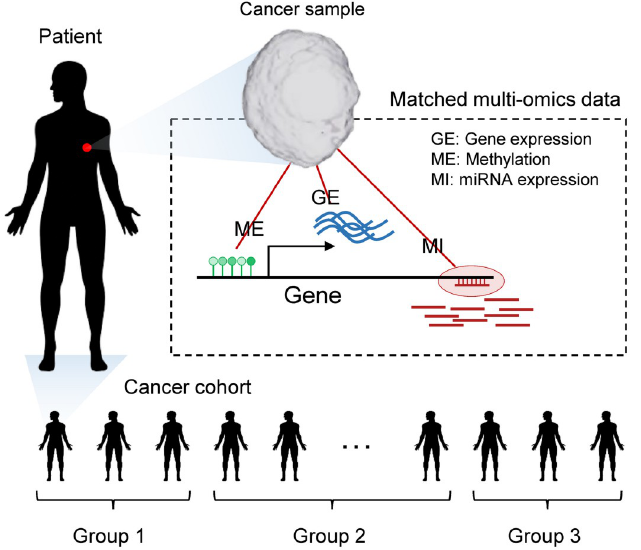
Fig 1. Description of patient matched multi-omics data. Multi-omics data are collected per patient in a multi-modal